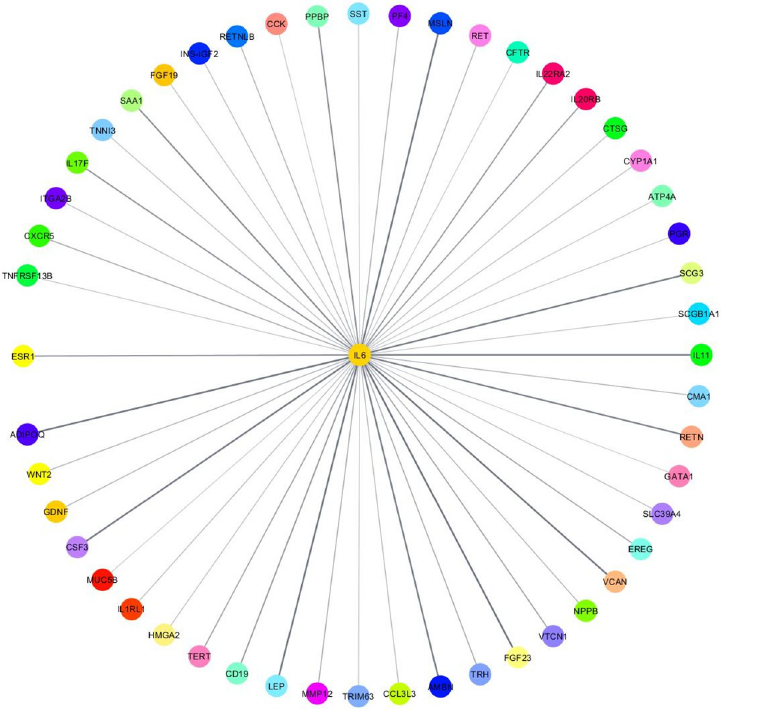
Fig 6. IL6 as a hub gene. IL6 has the highest degree of connectivity.